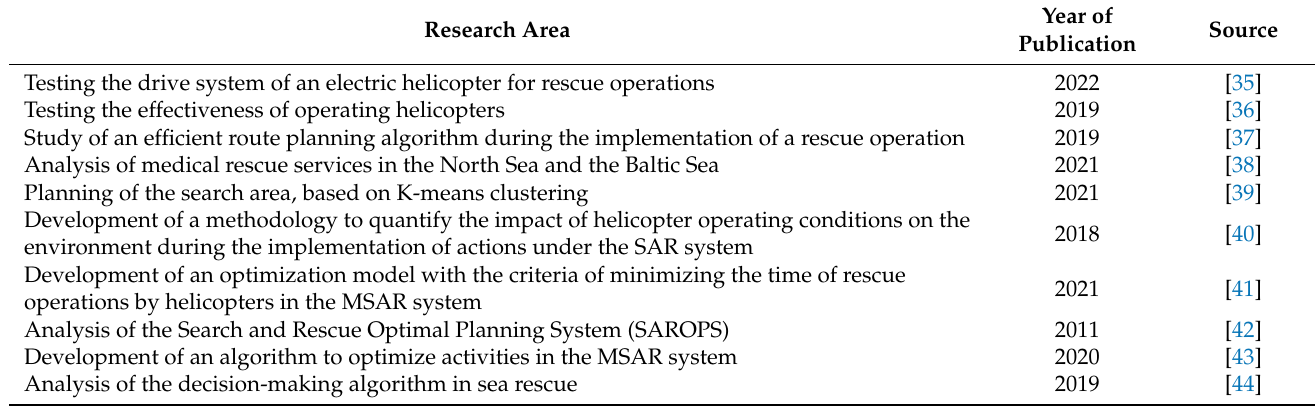
Table 2. Energy efficiency in the area of the SAR system; literature